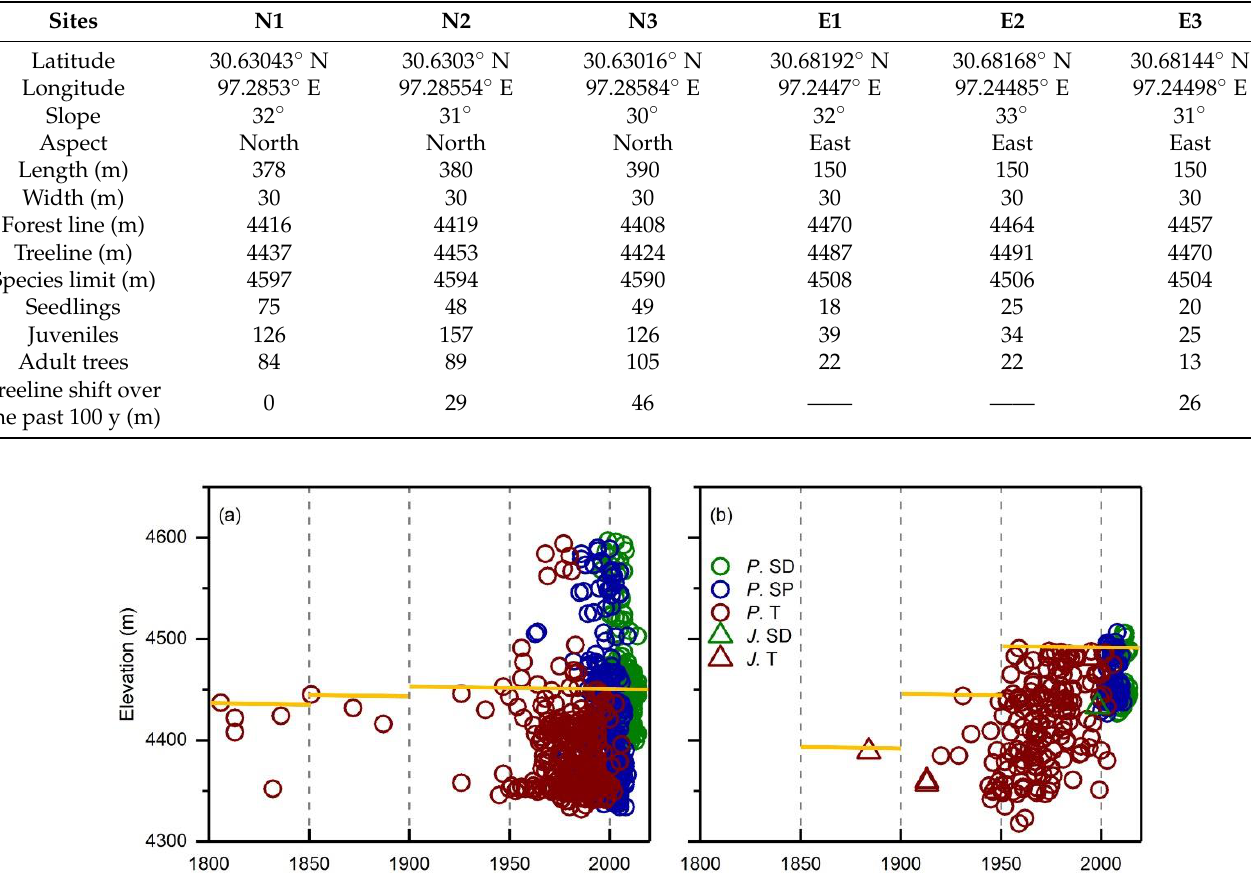
Figure 2. Elevation positions of Balfour spruce adult trees, juveniles, and seedlings on the north- ( a ) and east-facing slopes ( b ). Red color represents adult trees, blue color represents juveniles, and green color represents seedlings. Circles stand for Balfour spruce; triangles for junipers. P. SD stands for Balfour spruce seedlings, P. SP for Balfour spruce saplings, P. T for Balfour spruce adult trees, J .SD for juniper seedlings, J. T for juniper adult trees. Yellow lines indicate averaged treeline position.